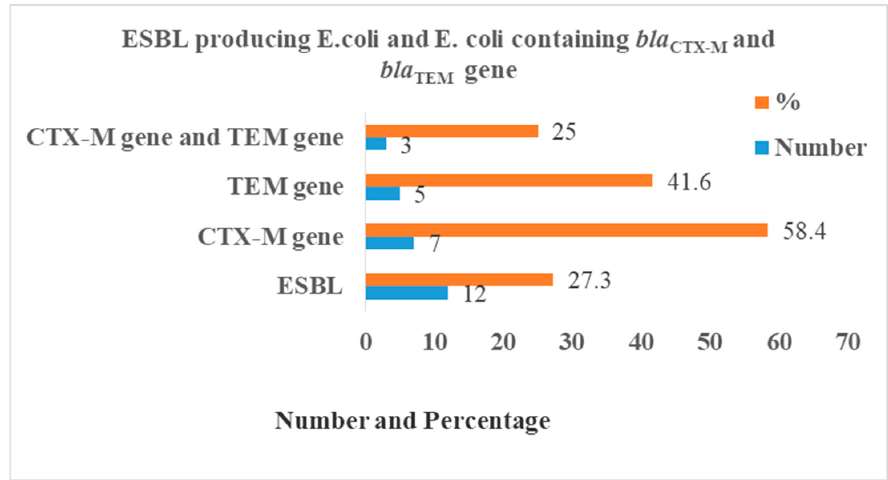
Figure 3. Distribution of bla CTX-M and bla TEM genes in E. coli.